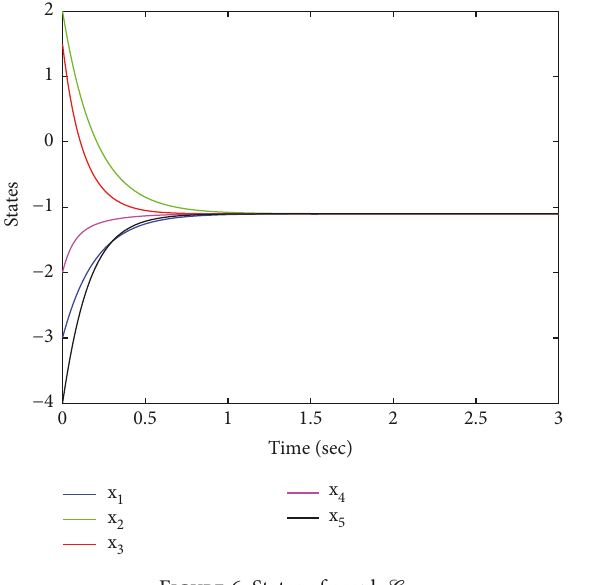
Figure 6: States of graph G . Figure 7: States of graph